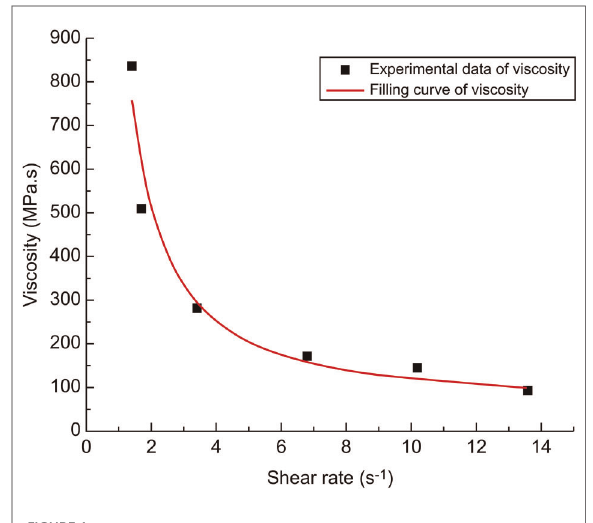
FIGURE 1 A plot of the viscosity fi tting characteristics at a temperature of 34 °C.